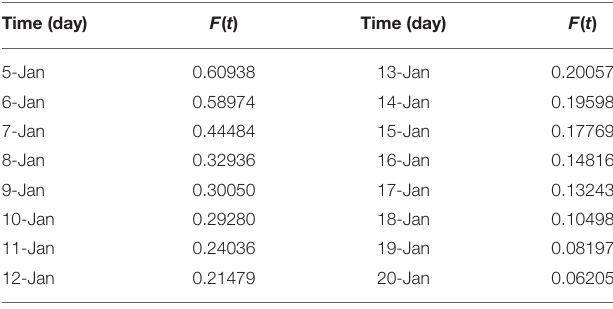
TABLE 3 | The daily successful infection rate of Hebei province during the outbreak in January